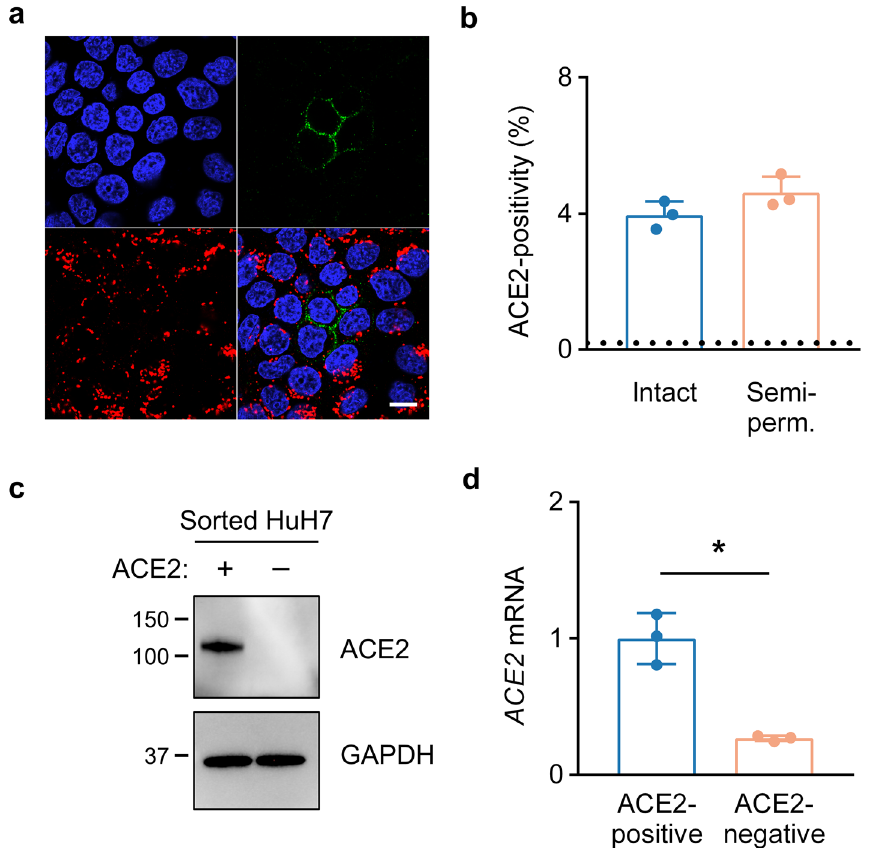
Figure 3. ACE2 heterogeneity in HuH7 cells is mediated at the mRNA level. ( a ) Immunofluorescence confocal microscopy of semi-permeabilized HuH7 cells with endogenous ACE2 (green), GM130 (red), and DAPI (blue) staining. Scale bar = 10 µm. ( b ) ACE2-positivity as determined by flow cytometry of intact or semi-permeabilized parental HuH7 cells. Dashed line represents background signal in cells stained only with secondary antibody. ( c ) Immunoblot of endogenous ACE2 (GeneTex #GTX01160) in lysates from FACS-sorted ACE2-positive and ACE2-negative HuH7 cells. ( d ) ACE2 transcript levels in FACS-sorted ACE2-positive and ACE2-negative HuH7 cells as determined by qRT-PCR. Asterisk indicates p < 0.05 by two-tailed Student’s t test. Error bars represent standard deviation. All ACE2 immunofluorescence and flow cytometry experiments in this figure were performed with R&D